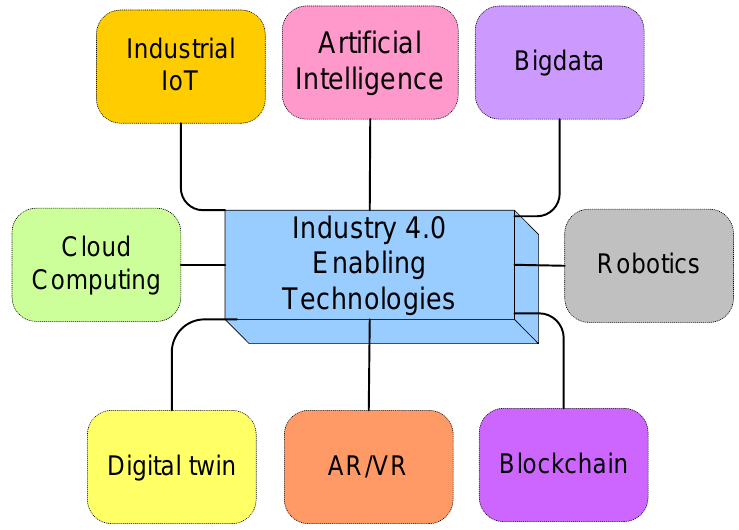
Figure 3. Enabling technologies of Industry 4.0.